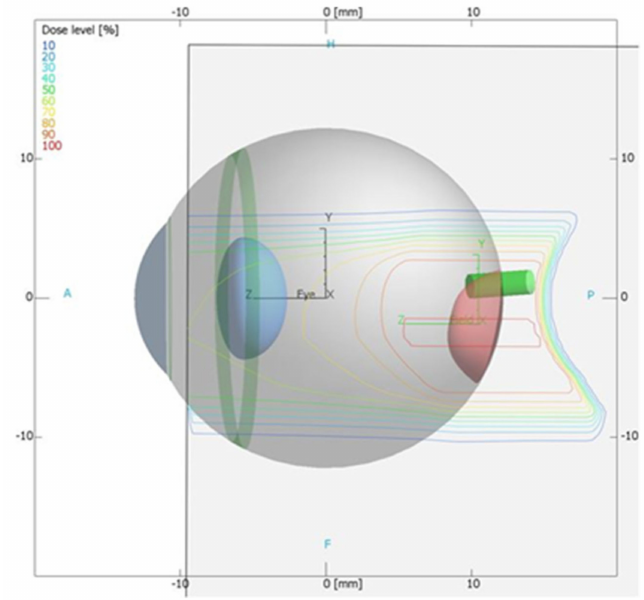
Figure 3. Lateral view, lateral orientation from the Eclipse Ocular Proton Planning system. The eye center (X-, Y- and Z-coordinates of the center point of the eye) is in black, the isocenter (X-, Y- and Z-coordinates) is in green. The isodoses represent the dose distribution on a Y-Z section though the isocenter.